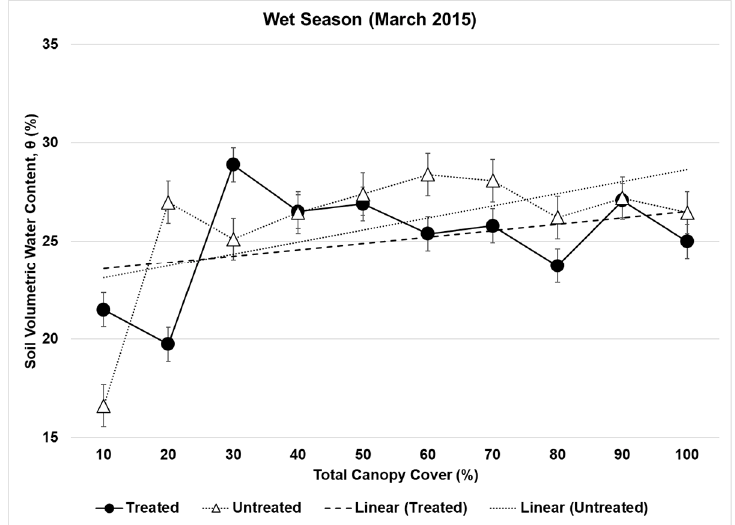
Figure 7. Mean θ (± SE) relative to total canopy cover (%) for the month of March 2015 (wet season) in both watersheds. Mean θ was estimated based on θ records from 143 transects in the treated watershed and from 146 transects in the untreated.